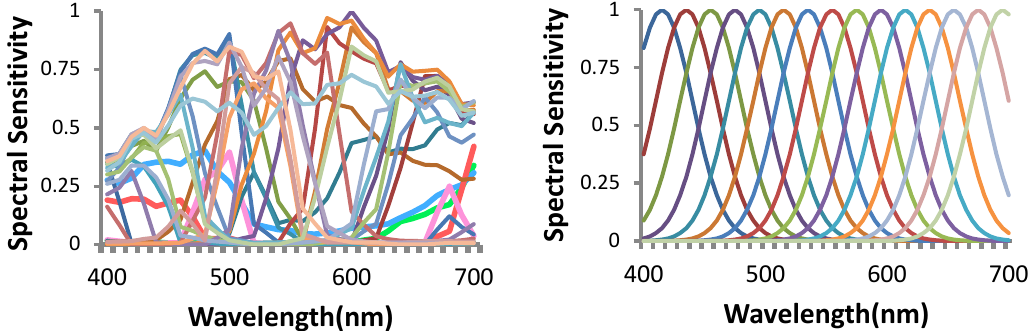
Figure 1. Left: commercial filter set; right: radial basis